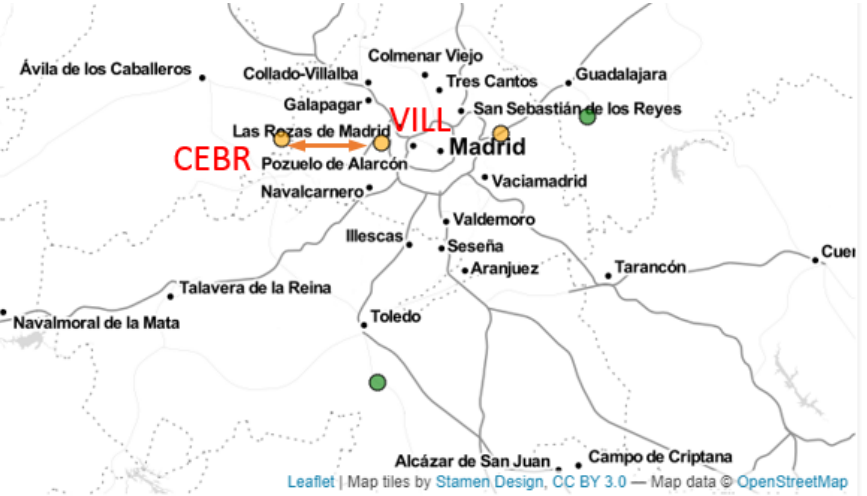
Figure 17. The reference stations of CEBR and VILL. (https://www.epncb.oma.be/_networkdata/stationmaps.php, accessed on 1 October 2021).